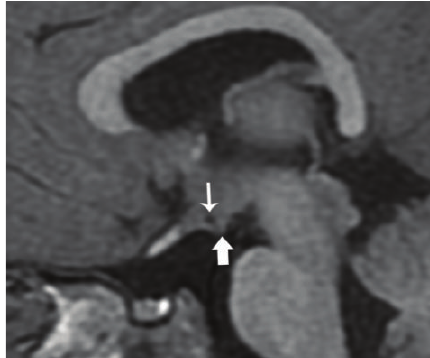
Figure 2: Parasagittal SPGR T1WI (repetition time msec/echo time msec/inversion time msec, 11/5/500) depicting a small diverticu- lum along the ventrolateral 3rd ventricular floor/tuber cinereum projecting into the suprasellar cistern (thick arrow). Note central hypointensity representing 3rd ventricular CSF within (thin arrow).